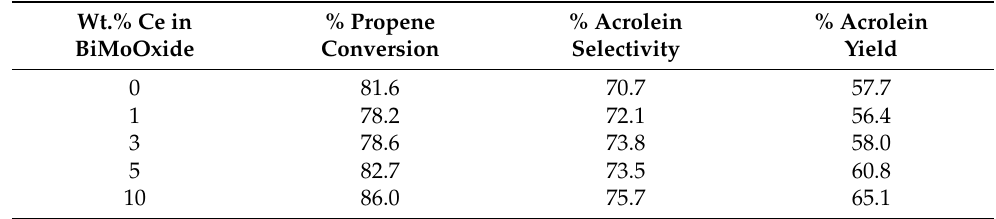
Table 1. Promoting the effect of cerium addition to a bismuth molybdate catalyst for selective oxidation of propene to acrolein